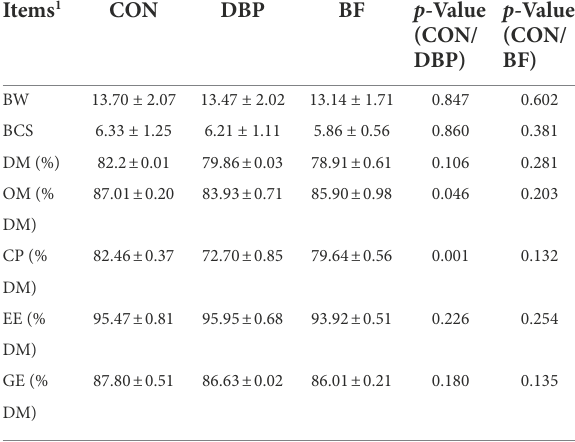
TABLE 2 Effects of DBP and BF on BW, BCS, and apparent nutrient digestibility in dogs. Items